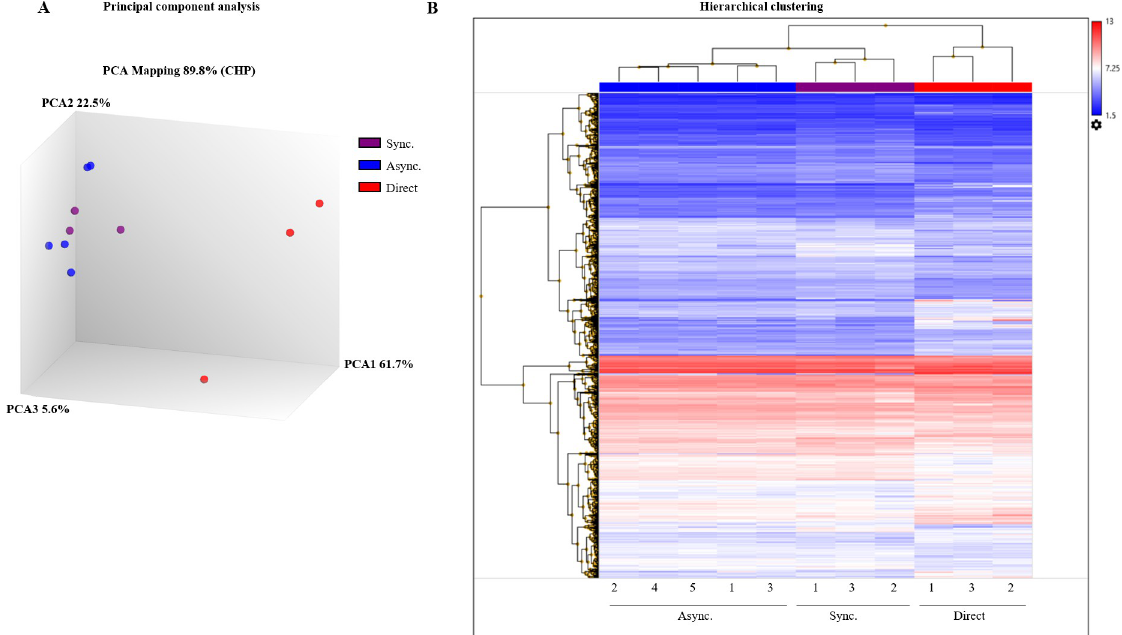
Fig 4. Differential gene expression in blastocysts that developed from synchronously, asynchronously, and directly cleaved embryos. (A) PCA plots. Purple, blastocysts from synchronously cleaved embryos (Sync); blue, from asynchronously cleaved embryos (Async); red, from directly cleaved embryos (Direct). Each symbol represents one replicate consisting of 4 blastocysts. (B) Hierarchical clustering (unsupervised) analysis of differentially expressed genes in blastocysts from synchronously, asynchronously, and directly cleaved embryos. Blastocysts from synchronously cleaved embryos are in 3 replicates (n = 4 blastocysts each) corresponding to samples Sync_1, Sync_3, and Sync_2; blastocysts from asynchronously cleaved embryos are in 5 replicates (n = 4 blastocysts each) corresponding to samples Async_1, Async_2, Async_3, Async_4, and Async_5; blastocysts from directly cleaved embryos are in 3 replicates (n = 4 blastocysts each) corresponding to samples Direct_1, Direct_3, and Direct_2. Colors indicate the expression levels of the detected genes: red, higher expressed; blue, lower expressed. Each horizontal line represents a single gene, and each column represents a single sample from each group. Left branches indicate the relationships among different genes and the upper branches indicate differences among samples. synchronously vs. the unequally cleaved embryo groups ( P < 0.001; Fig 3C). The proportion of poor grade embryos was lower in the synchronously cleaved embryos relative to the unequally cleaved embryos ( P < 0.006; Fig 3C). The distribution of the reverse-cleaved embryos into the morphological grades did not differ from that of synchronously cleaved embryos ( P = 0.8), but it did differ from that of the unequally cleaved embryos ( P < 0.001; Fig 3C). This was reflected by (1) a higher proportion of good grade embryos ( P < 0.001) and (2) a lower proportion of fair grade embryos ( P < 0.006) in the reverse-cleaved vs. the unequally cleaved embryos. The distribution of asynchronously cleaved 3-cell stage embryos into mor- phological grades did not differ from that of the embryos directly cleaved into 3 cells ( P = 0.6; Fig 3C). In addition, the distribution of embryos into morphological grades did not differ between normally cleaving embryos that cleaved through two synchronous cleavages into 4 cells, compared with those that cleaved directly into the 4-cell stage ( P = 0.8; Fig 3C). Blastocyst morphology. The morphology of blastocysts that developed from synchronously, asynchronously, and directly cleaved embryos was also defined as good, fair, or poor (Fig 3D). Only four of the unequally cleaved embryos developed to blastocysts and none of the reverse- cleaved embryos did. No difference was found between the distribution of the synchronous-, asynchronous-, and direct-cleavage blastocysts into morphological grades ( P = 0.9; Fig 3E). Transcriptome profiles. Blastocysts that developed from synchronously, asynchronously, and directly cleaved embryos were subjected to microarray analysis. A total of 24,415 genes